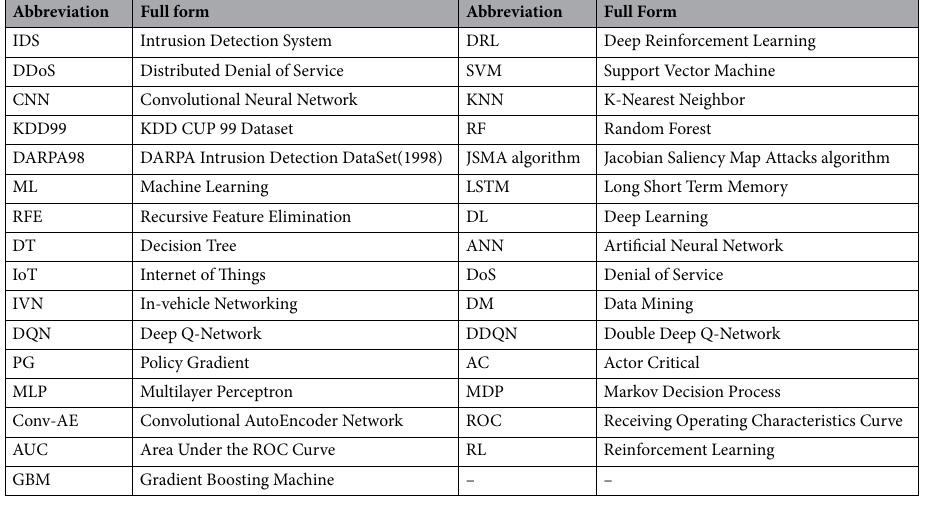
Table 1. List of abbreviations. Sorting according to the order of appearance in the